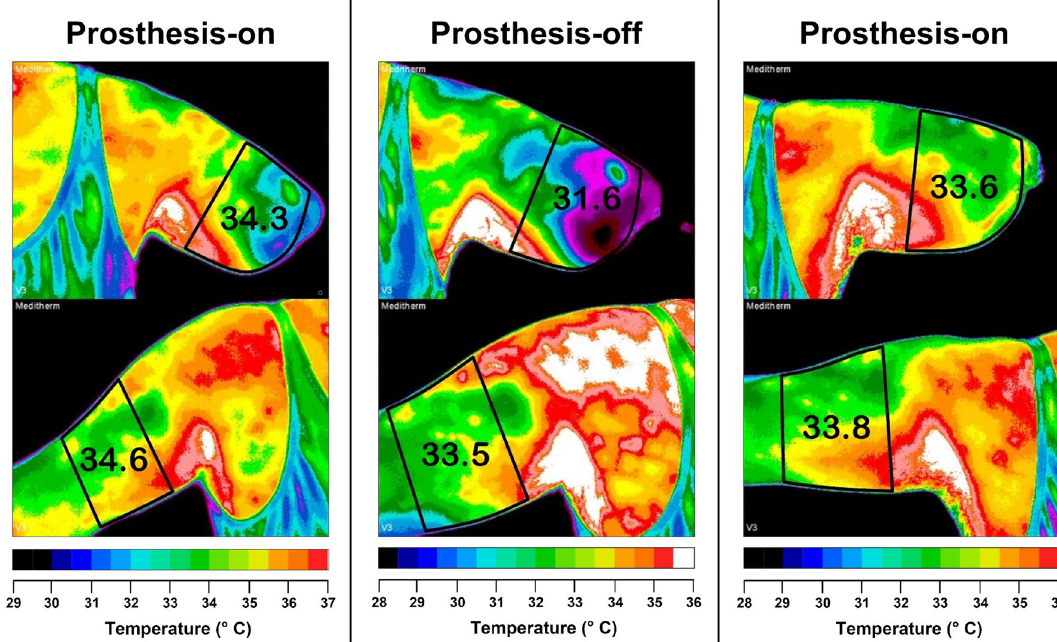
Figure 1. Neuromusculoskeletal prosthesis users had thermal images taken three times on two consecutive days: (1) Prosthesis-on, (2) Prosthesis-off for 15.72 h (SD = 1.58), and (3) Prosthesis-on again for 7.22 h (SD = 1.82). The lateral temperature differences across the three columns are 0.3 °C, 1.9 °C, and 0.2 °C, in this